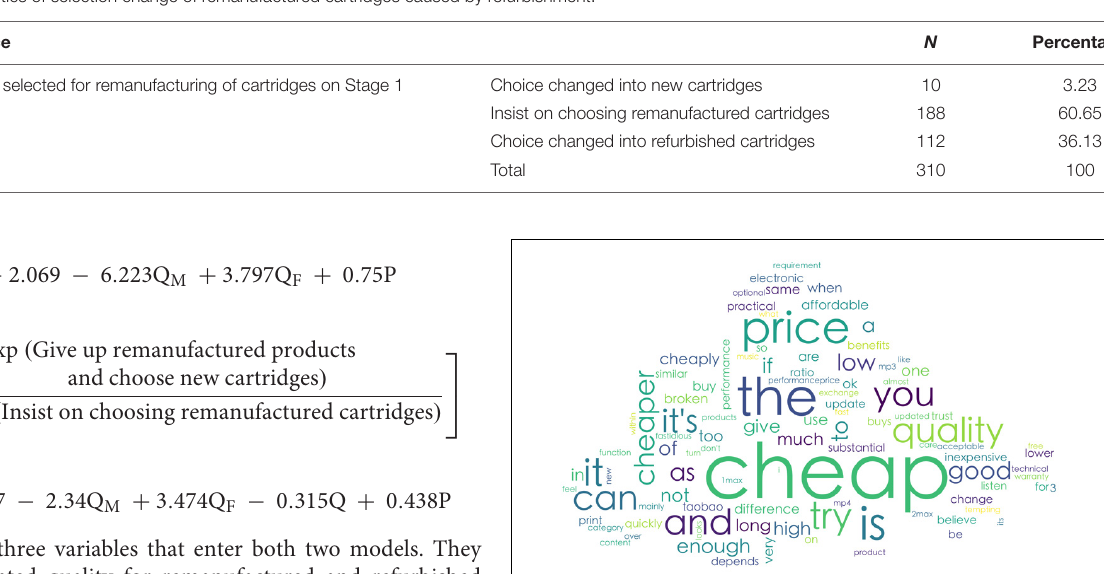
TABLE 5b | Statistics of selection change of remanufactured cartridges caused by refurbishment.